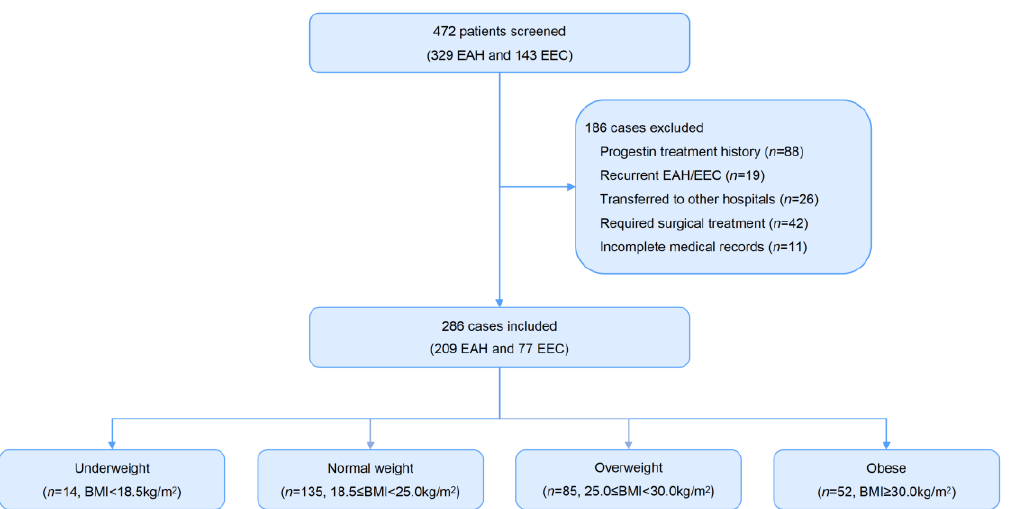
Figure 1. Flow chart of study population selection. EAH, endometrial atypical hyperplasia; EEC, endometrioid endometrial